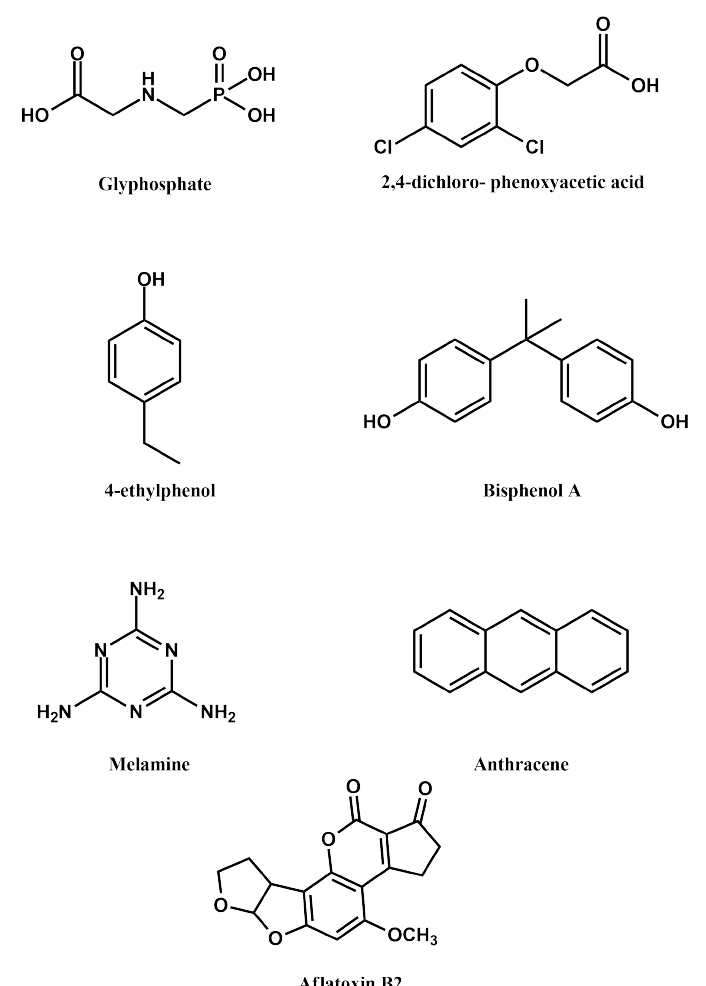
Figure 6. Structural formulae of some non-drug contaminants that can be detected using MIPPy- based